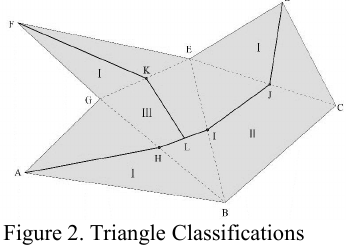
Figure 2. Triangle Classifications